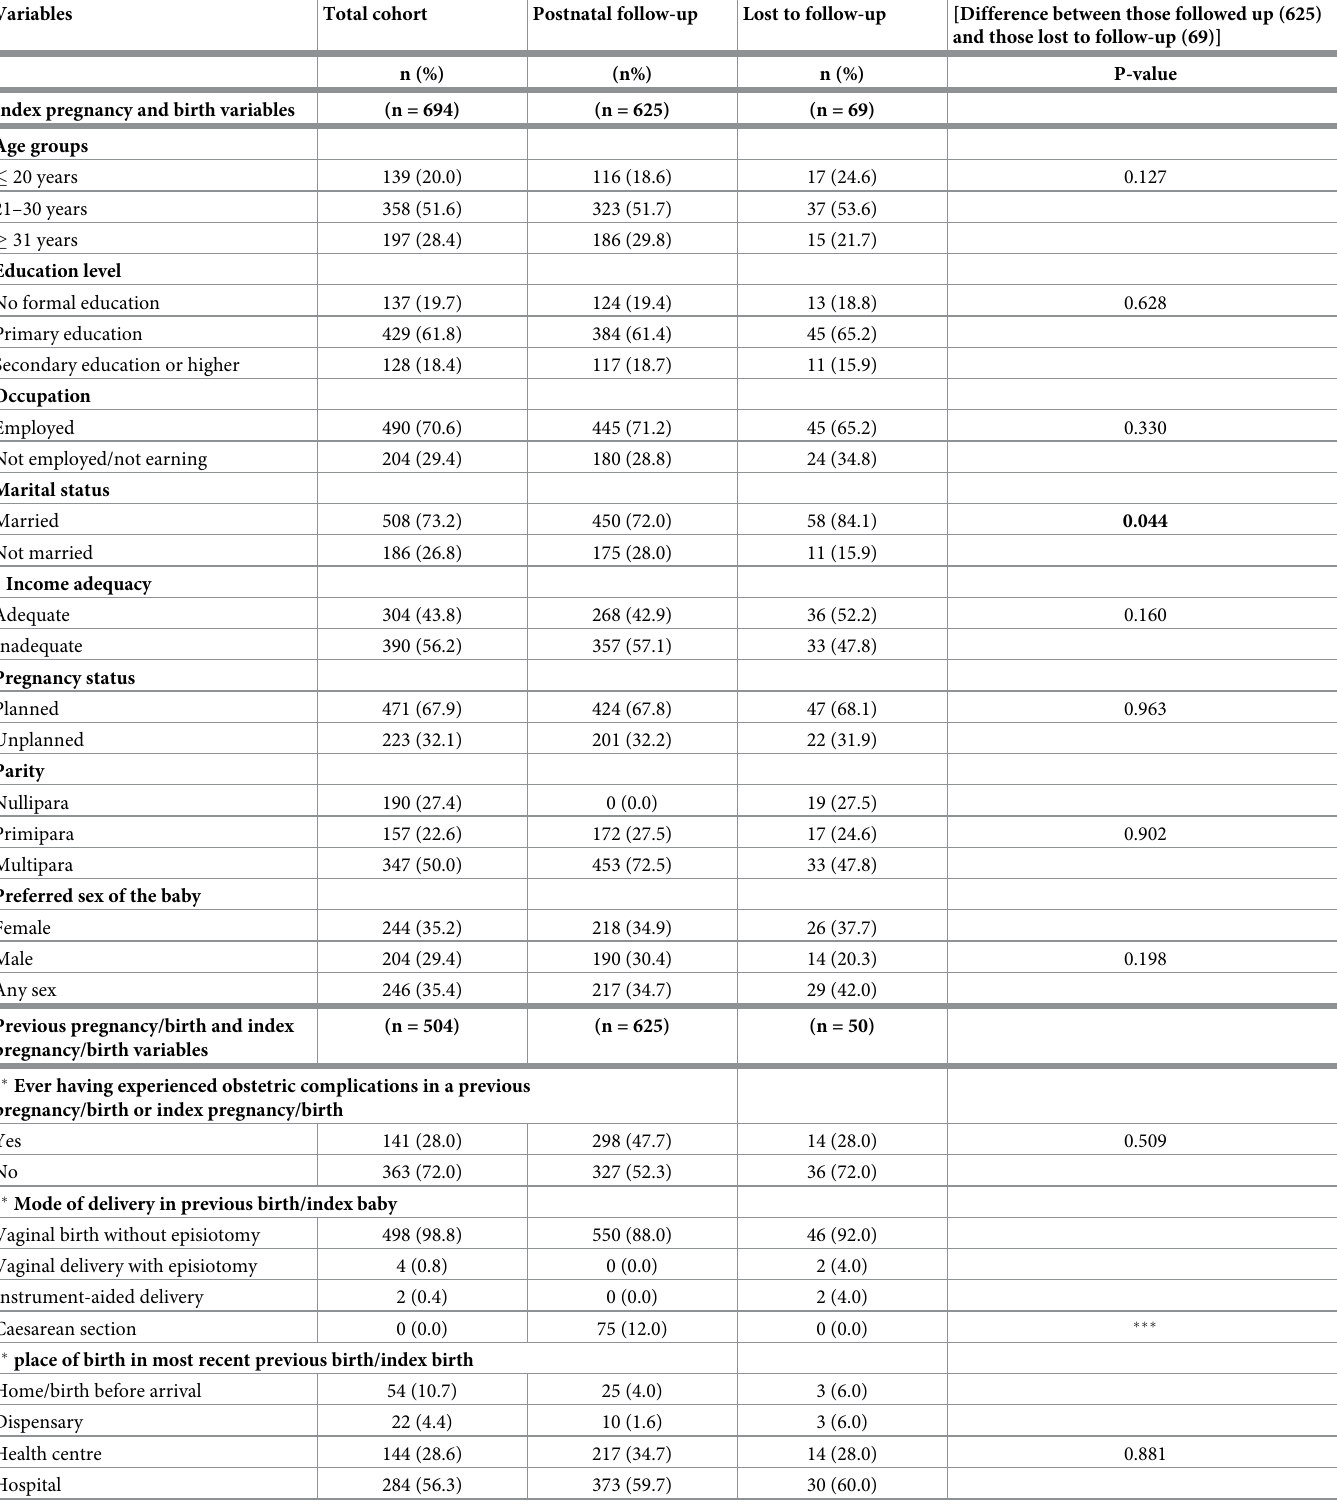
Table 1. Sociodemographic and obstetric characteristics of the